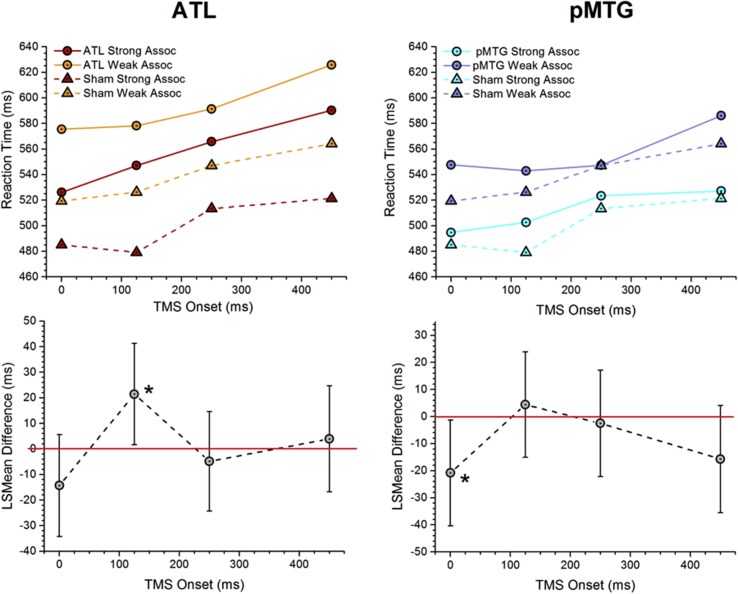
Effect of TMS on RT for strong and weak associations. TOP ROW: RT (in msec) for the strong and weak conditions for ATL (left) and pMTG (right). RT data for the strong and weak condition for the sham site is showed in dashed lines. These plots show the raw (un-modelled) means. BOTTOM ROW: A comparison of LS means differences between strong and weak conditions in the effect of TMS. Data points above the red line indicate greater disruption for the strong condition, while data points below the red line indicate greater disruption for the weak condition. Statistically significant differences (at p < .05) between the effects of TMS on strong and weak trials are indicated with asterisks. Error bars show 95% confidence intervals.